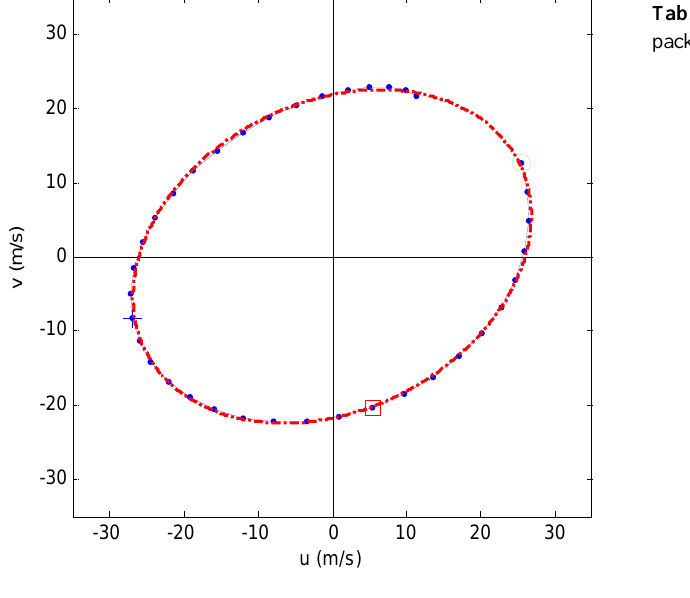
Fig. 8. Hodograph at t = 250 1t and height range 105 1z − 141 1 z of Fig. 6b. Least square fitting by an ellipse yields τ = 15 . 45h and Fig.8 Hodograph at of Fig.6b. Least square fitting ϕ az = 63 . 3 ◦ . The rotation sense of this hodograph is clockwise.